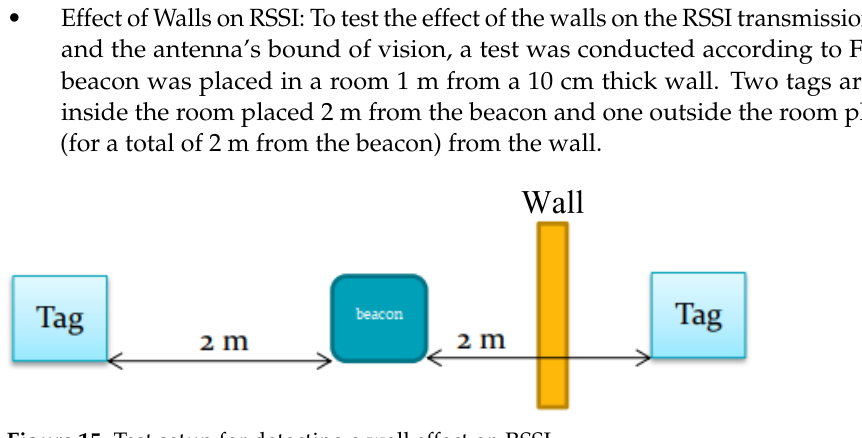
Figure 15. Test setup for detecting a wall effect on